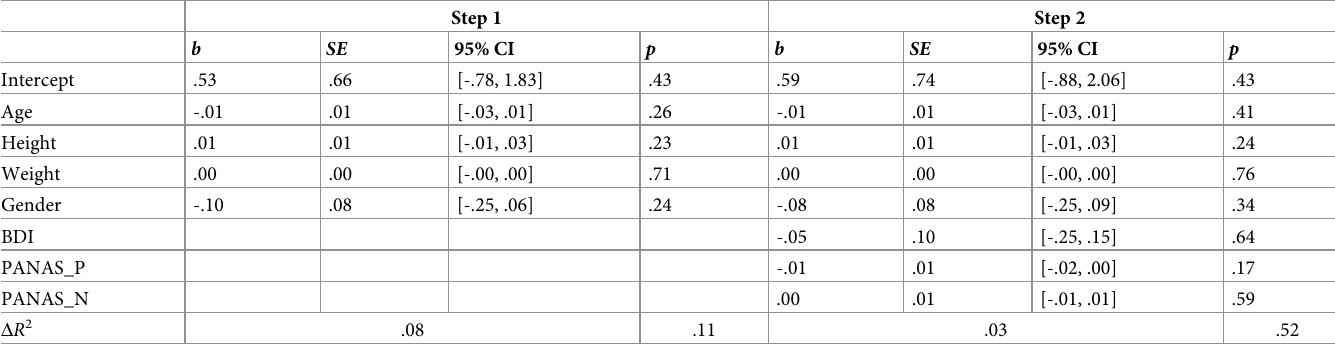
Table 3. Regression results for gait